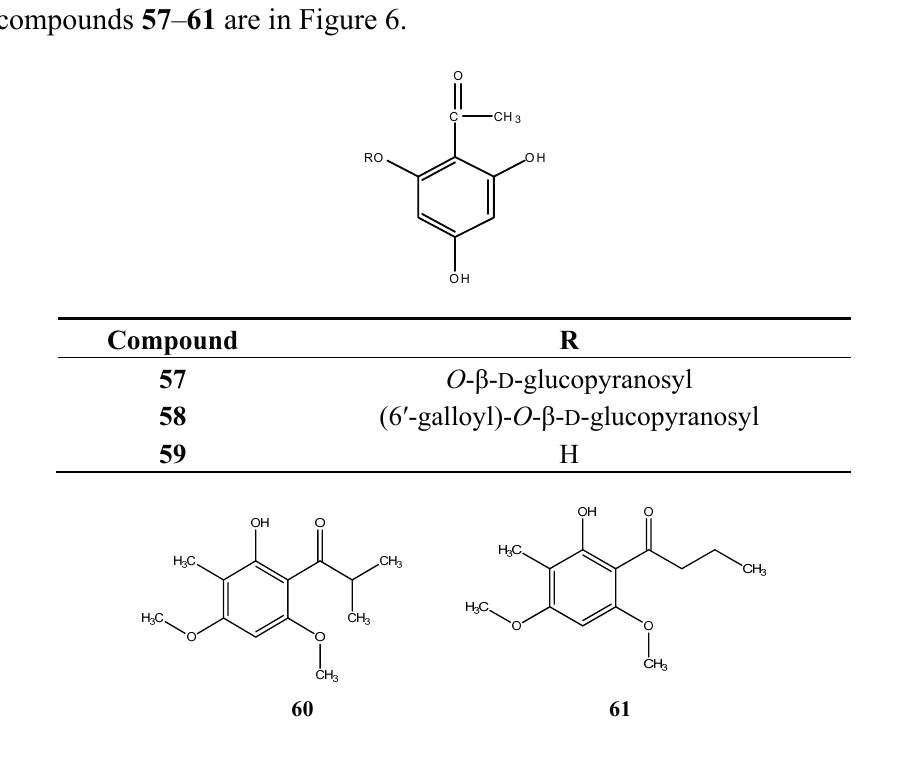
Figure 6. Acetophenones and derivatives from Myrcia species.